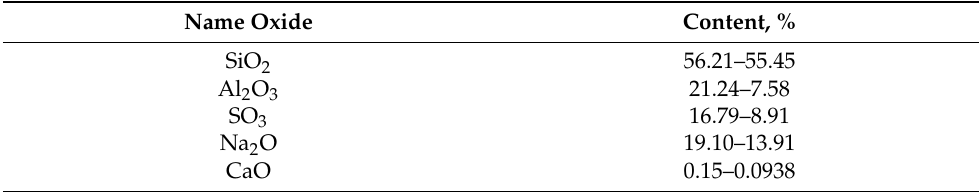
Table 3. The content of chemical elements in the additive based on synthetic aluminosilicates, %. The Content of Chemical Elements in Weight%